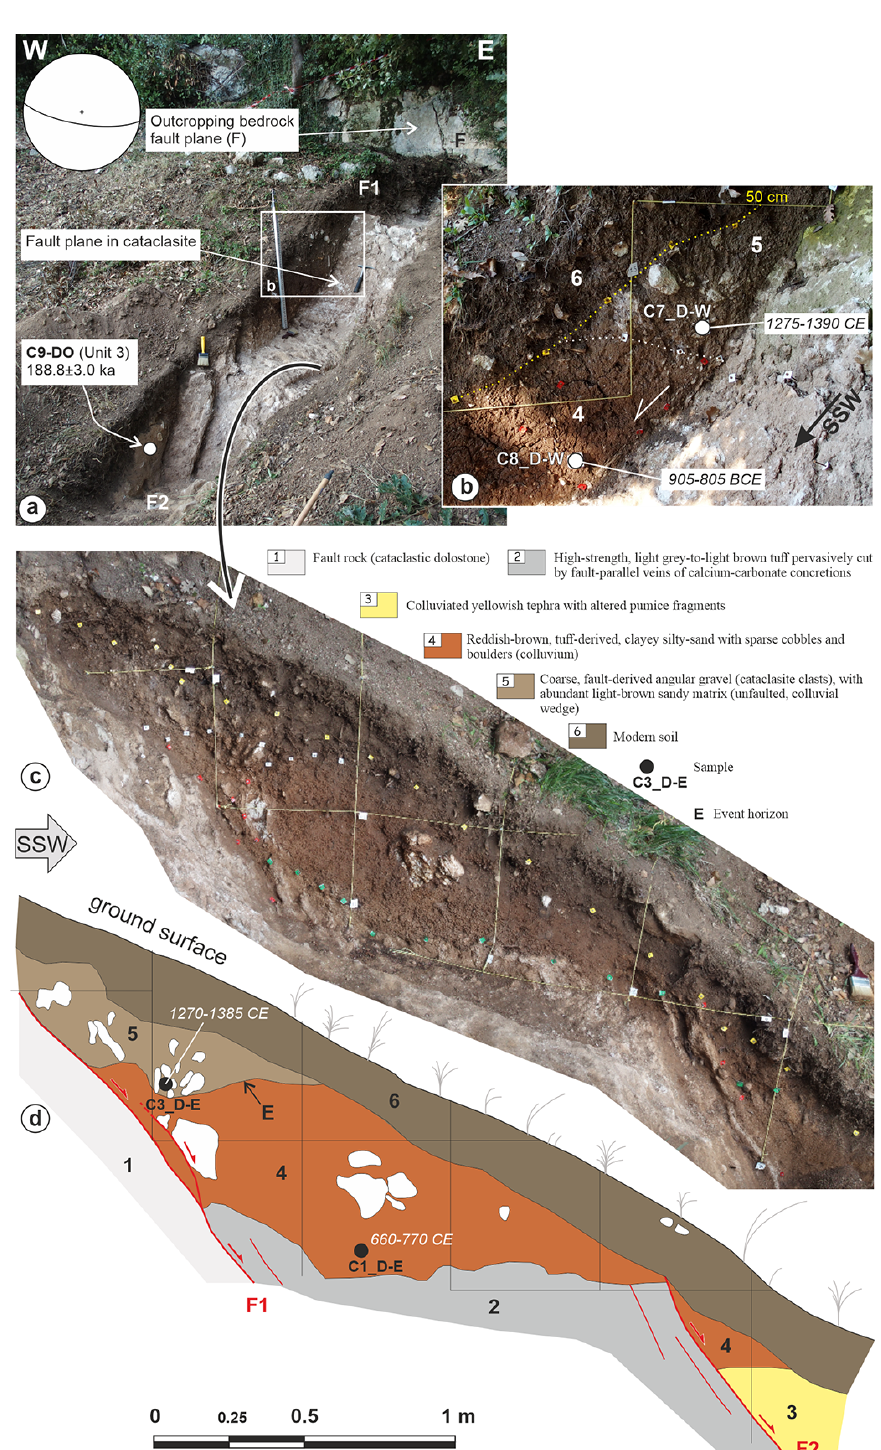
Figure 10. Field view from the northern wall (a) , a more detailed view of the same wall (b) , and a photomosaic and log of the southern wall (c,d) of a shallow hand-dug trench across the southern Ailano–Piedimonte Matese fault (Raviscanina fault section, southern area) near Sant’Angelo d’Alife. Unit numbering (1 to 6) refers only to this outcrop (units do not necessarily correlate with other units with the same number in Figs. 8 and 9); units 3 to 6 belong to unit sd2 shown in Fig. 3. Fault numbering (F1, F2) refers only to this outcrop (not the same as that in Figs. 8 and 9). Event horizon (E) refers to the topographic surface at the time of the last surface faulting event. The complete details of the age determinations are given in Tables 1, 2, and S1. The location of this area is shown in Fig. 2a.